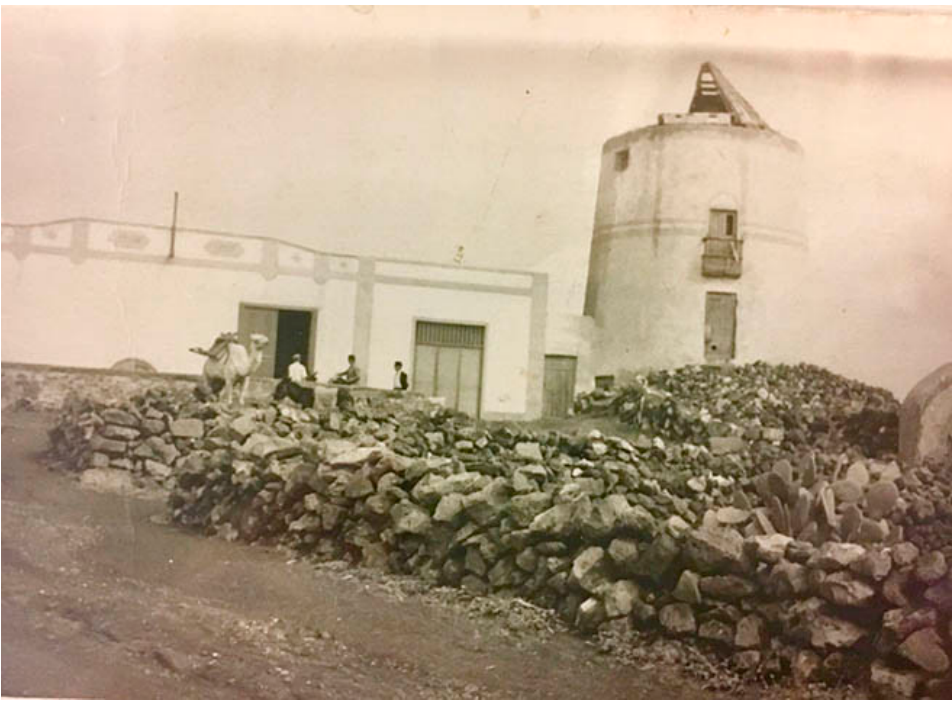
Figure 14. Flour mill of SB (1870), erected by Baltasar Ferm í n and acquired by Jos é Mar í a Gil in 1919, today declared a Site of Cultural Interest